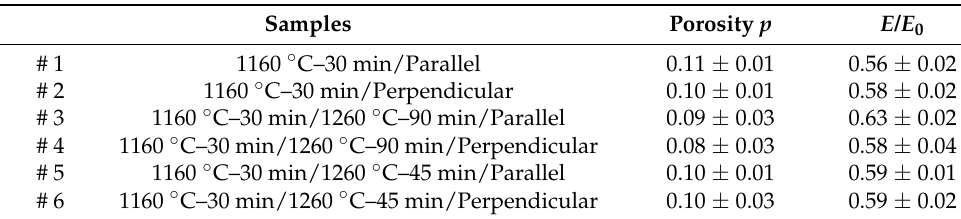
Table 4. Porosity p and relative modulus E r of the steel sintered in three different conditions. The reeds have been cut in two different directions, parallel and perpendicular to the disk axis. Samples Porosity p E/E 0 # 1 1160 ◦ C–30